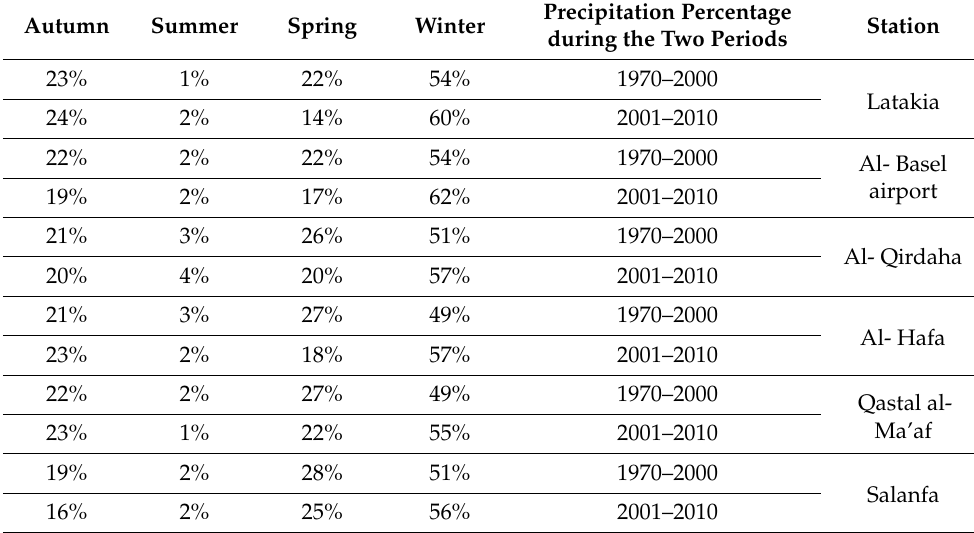
Table 3. Percentage of seasonal precipitation from the total during the two periods (2001–2010 and